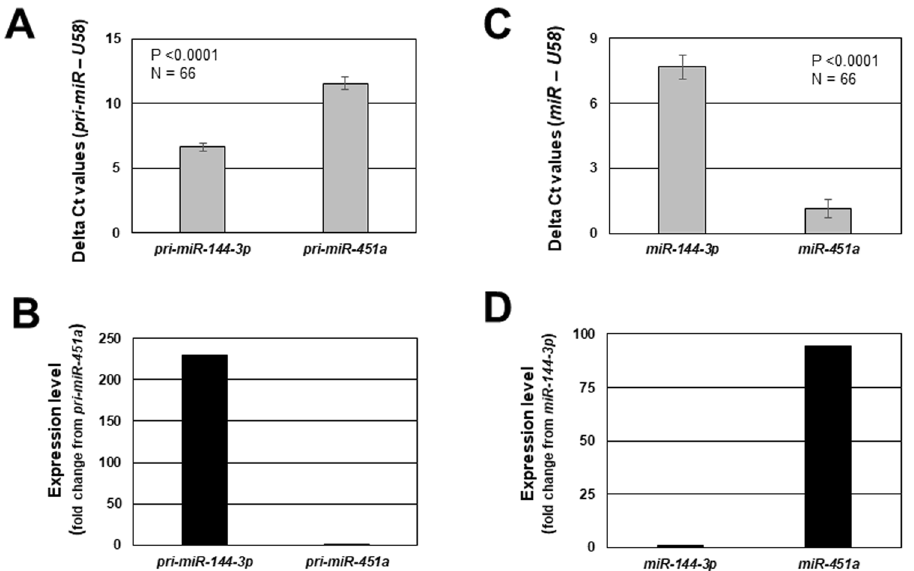
Figure 5. Comparison of average pri- and mature miR-144-3p and miR-451a expression in endometriotic lesion tissue. Pri- miR-144-3p and pri- miR-451a expression are presented as delta ct values ( A ) and fold change from pri- miR-451a ( B ) while mature miR-144-3p and miR-451a are presented as delta ct values ( C ) and fold change from miR-144-3p ( D ). These data are presented to emphasize the greater level of pri- miR-144-3p expression compared pri- miR-451a , but the greater expression of mature miR-451a despite the low levels of lesion pri- miR-451a